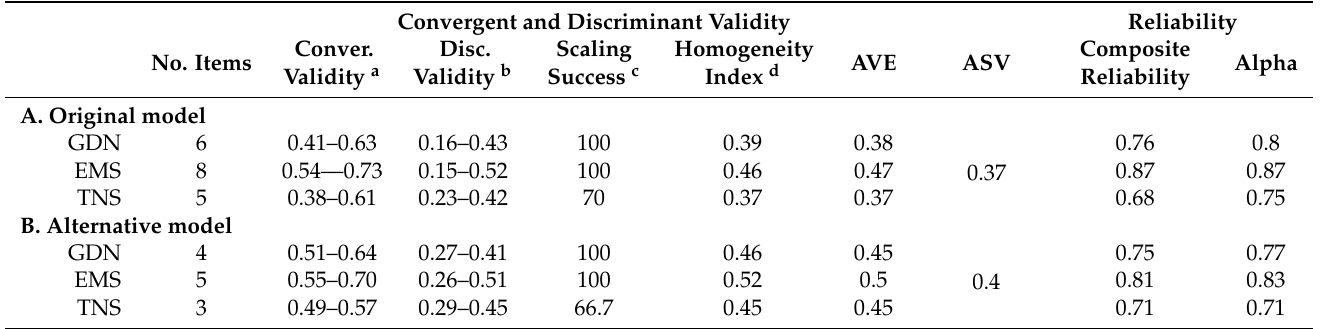
Table 2. Validity and reliability of the original and alternative model. Convergent and Discriminant Validity